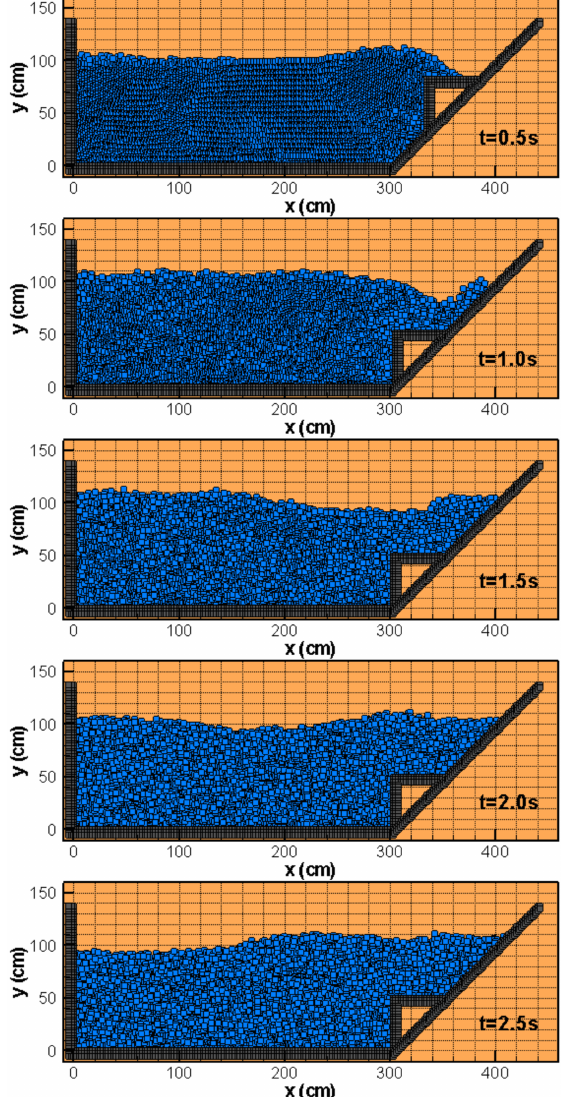
Figure 11. Particle configuration for submarine landslide computed by the WC-MPS